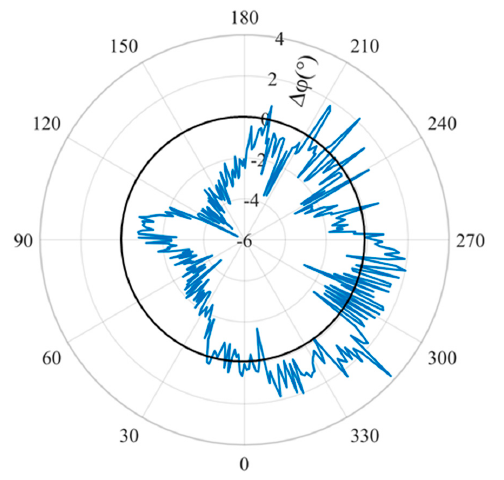
Figure 8. Robustness investigation result for FPDD : ∆ ϕ for α = 0 ◦ , 1 ◦ , ... , 360 ◦ .